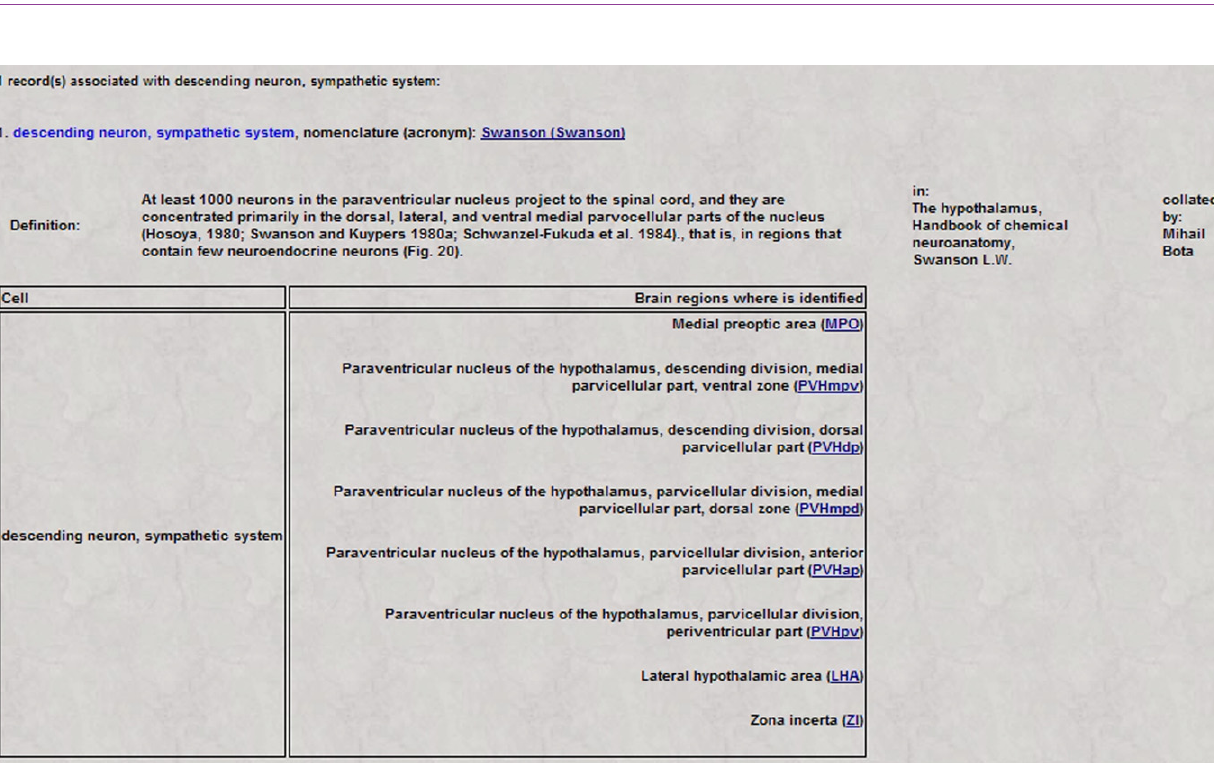
Figure 5. BAMS Neuroanatomical Ontology web interface allows users to view those brain regions where the neuron type or class of interest was identifi ed. Links are associated with each brain region abbreviation, and they return descriptions of the regions, as recorded in BAMS (Bota et al., 2005; Bota and Swanson,